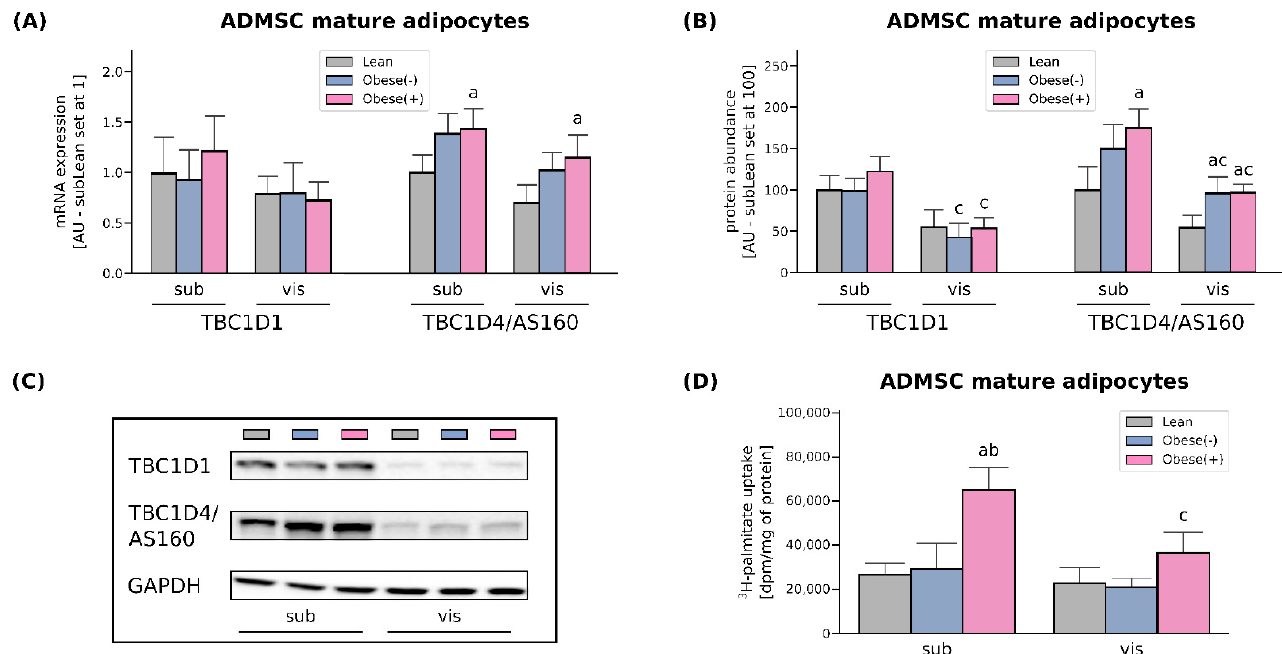
Figure 2. Gene ( A ) and protein expression ( B ) of AS160/TBC1D4 and its structural homolog TBC1D1 in adipocytes differentiated from ADMSCs derived from SAT and VAT of lean and morbidly obese women. Values are expressed in arbitrary units; the mean in adipocytes differentiated from the subADMSCs’ lean control was set at 1 or 100, respectively. ( C ) Representative Western Blot images are shown. ( D ) Measurement of 3 H-palmitate uptake in fully differentiated adipocytes from subADMSCs and visADMSCs of lean and morbidly obese women. Values are expressed in DPM per mg of protein. a–difference vs. Lean group in the studied tissue; b–difference vs. Obese(-) group in the studied tissue; c–difference between adipocytes differentiated from visADMSCs vs. subADMSCs within the patient metabolic status. Data are presented as mean ± SD ( n = 4 for each study group, measurements taken in duplicate for LCFA uptake and n = 3 for WB analysis). p < 0.05. Designation of the groups: Obese(-)–obese without metabolic syndrome patients; Obese(+)–obese with